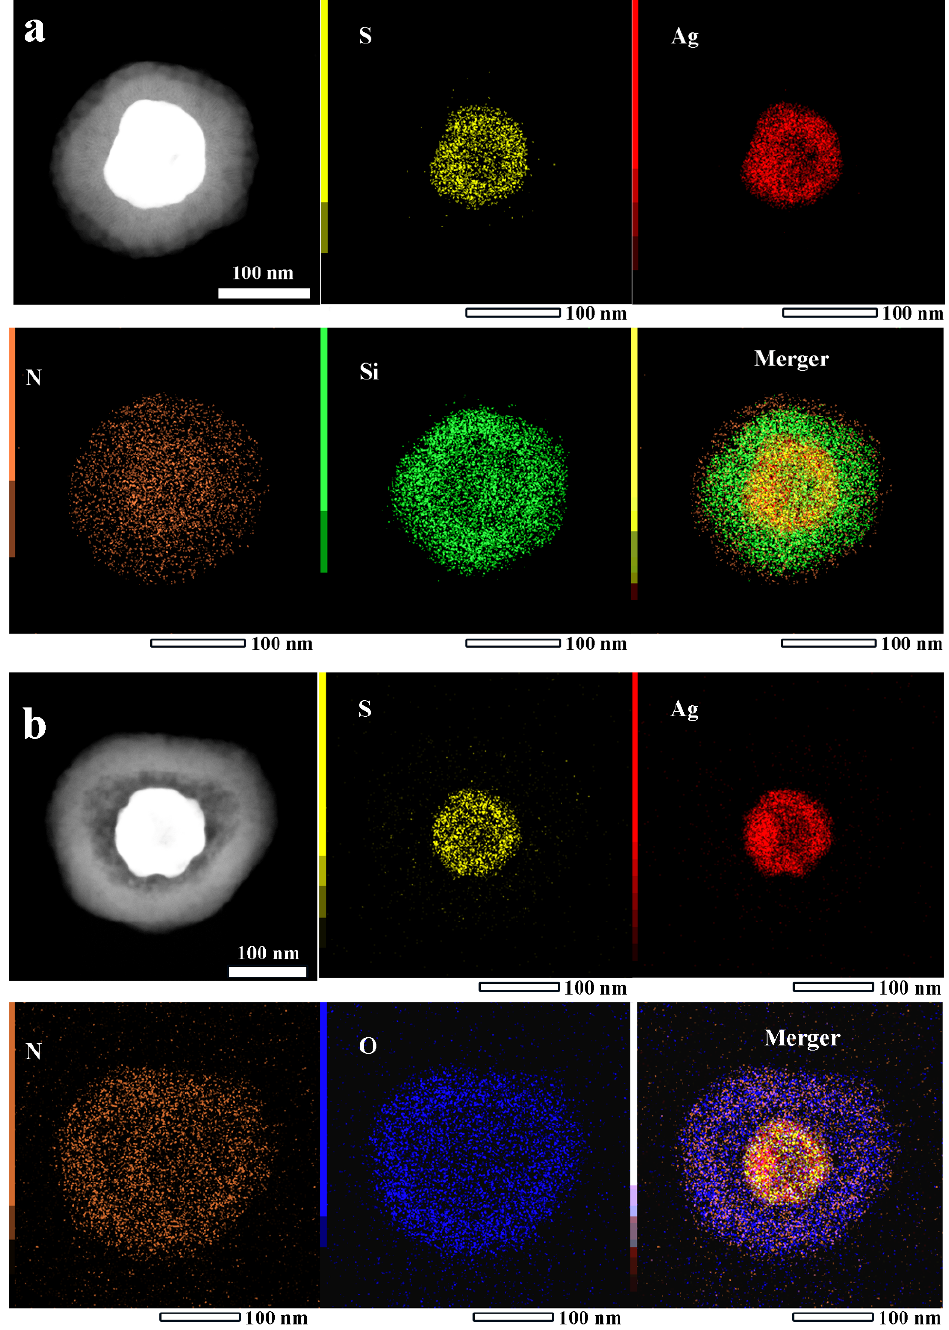
Figure 3. High-angle annular dark-field images and EDX elemental mappings of HAg 2 S@mSiO 2 @MPDA ( a ) and HAg 2 S@HMPDA/PEI ( b ); the scale bar is 100 nm.